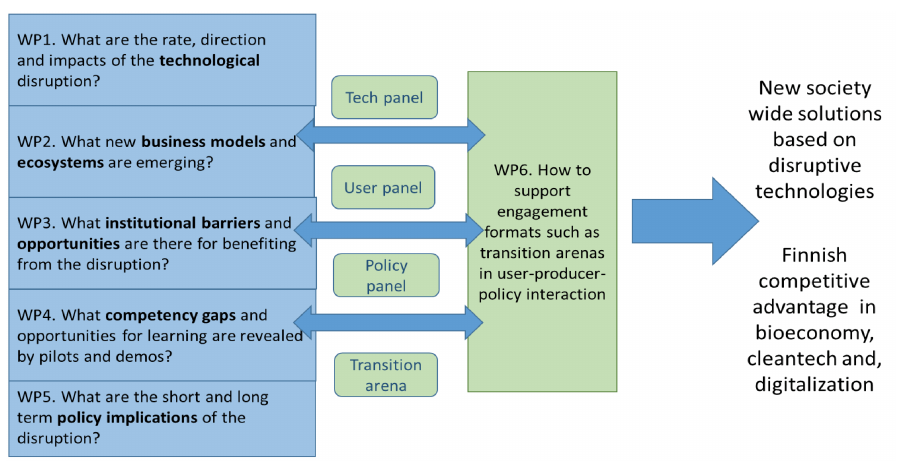
Fig. 4. Description of work packages in the SET project (SET,